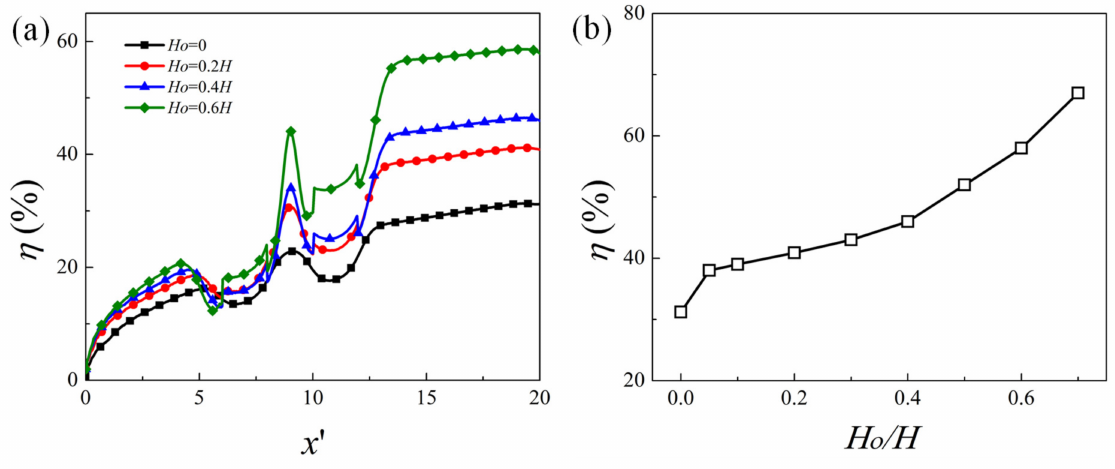
Figure 7. ( a ) Evolution of the mixing efficiency along the channel length direction for obstacle height H o = 0,0.2 H ,0.4 H ,and 0.6 H , ( b ) the dependence of the mixing efficiency at the outlet as a function of ratio H o / H